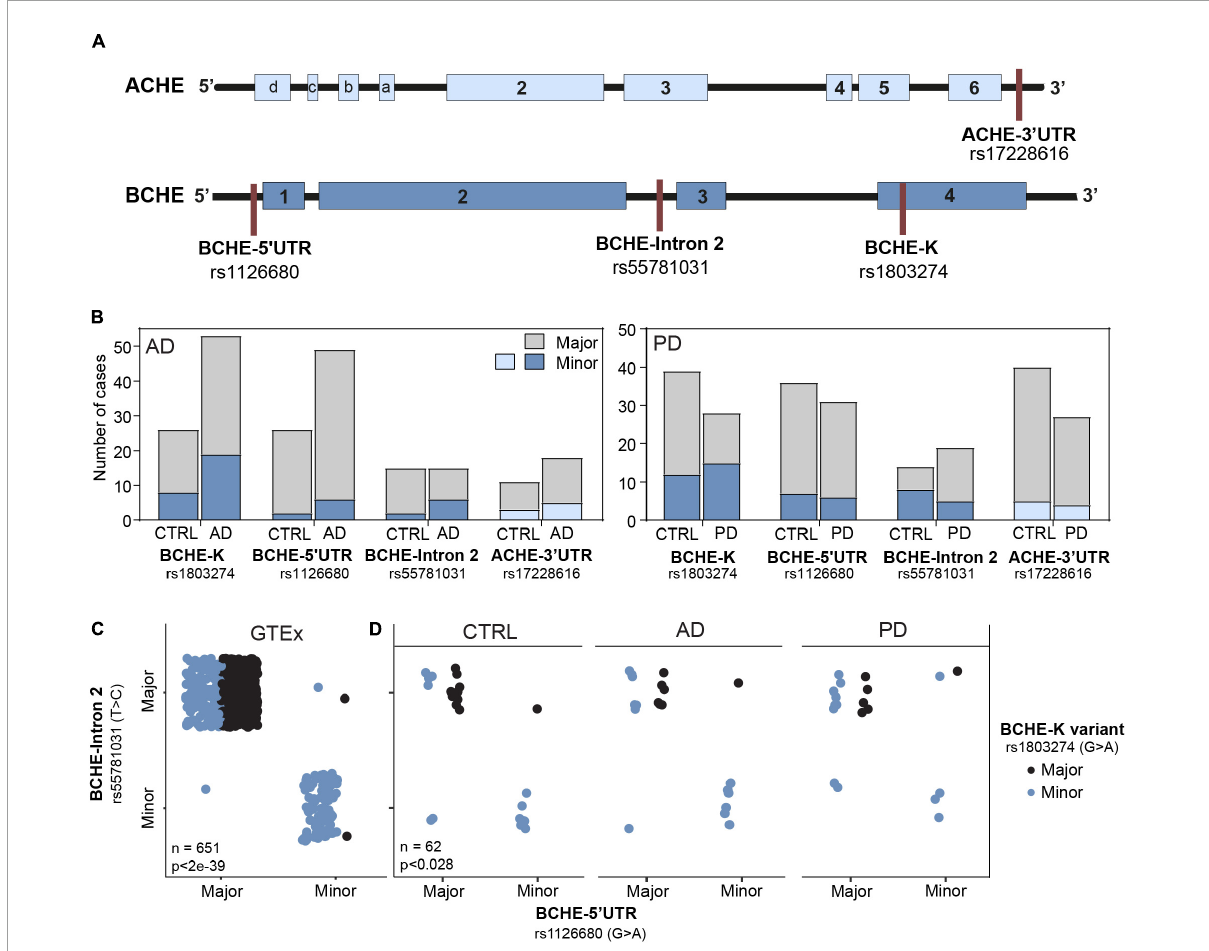
FIGURE2 Altered prevalence of ACHE and BCHE SNPs in AD and PD patients compared to non-demented controls. (A) Loci of SNPs in the BCHE (K allele, rs1803274), 5 (cid:48) -UTR (rs1126680), and intron 2 (rs55781031), and of 3 (cid:48) -UTR ACHE SNP (rs17228616). SNPs were studied in AD ( n = 79) and PD ( n = 67) patients and in the genomic dataset of the GTEx healthy donors ( n = 651). (B) The SNPs in the 5 (cid:48) -UTR (rs1126680) and intron 2 (rs55781031) of the BCHE gene, as well as the 3 (cid:48) -UTR ACHE SNP (rs17228616), showed similar occurrence in the diseased and healthy cohorts of AD and PD. (C) In the GTEx cohort, carriers of the 5 (cid:48) -UTR BCHE SNP (rs1126680) tended to carry the BCHE SNP in intron 2 (rs55781031) but did not show distinct prevalence of the coding sequence BCHE-K allele (rs1803274). (D) Both AD and PD donors of our small cohorts showed higher prevalence of the BCHE-K minor allele (rs1803274) compared to